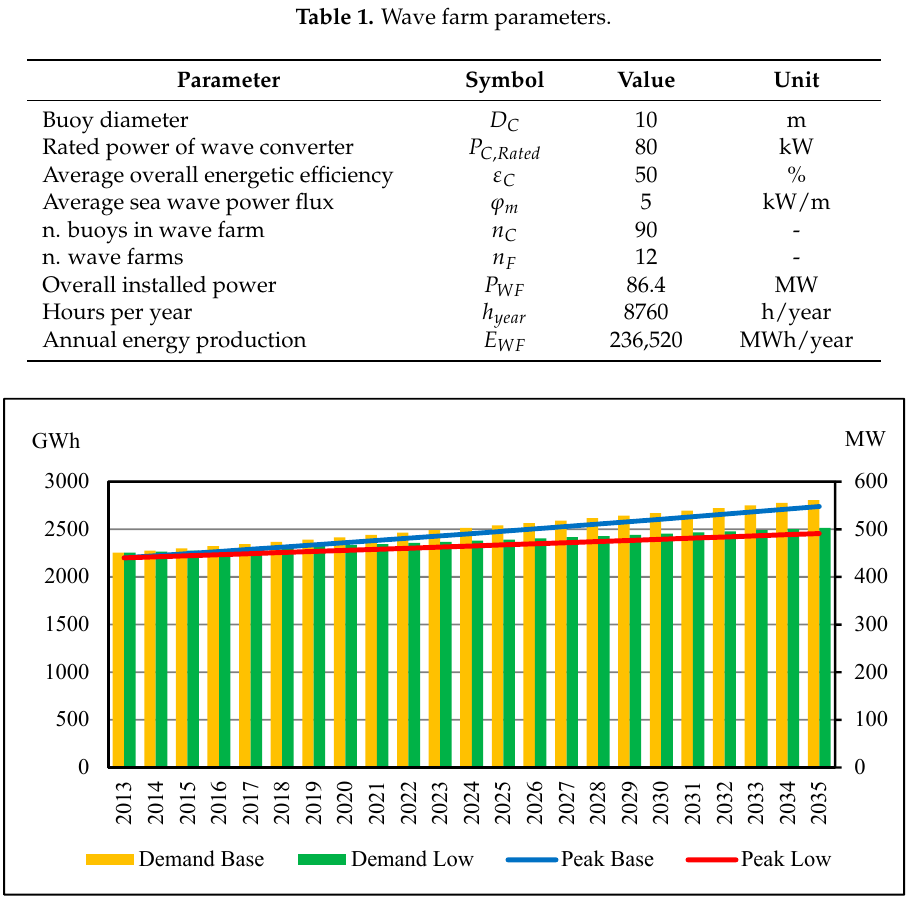
Figure 14. Maltese annual energy and peak demand projections until 2035 [27].